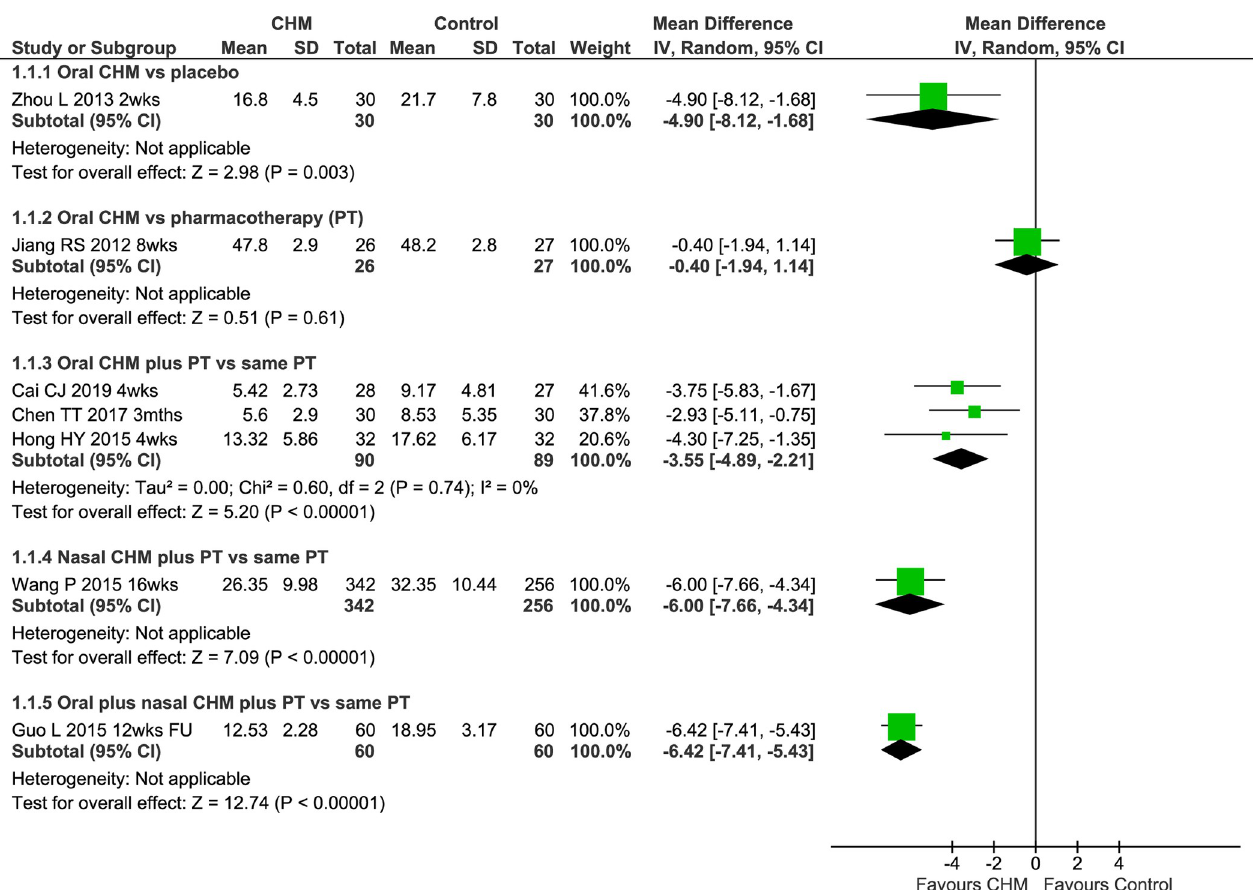
Fig 2. Forest plot of CHM for CRS at end of treatment for SNOT-20 total score. Abbreviations: CHM: Chinese herbal medicine; CRS: chronic rhinosinusitis; DB: double blind; FU: follow-up; SNOT-20: Sino-Nasal Outcome Test-20; PT: pharmacotherapy; vs: versus; wks: weeks.